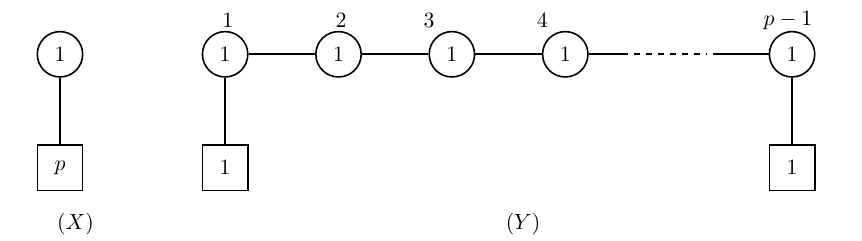
Figure 33 . The pair of Lagrangian theories associated with the 3d N = 4 SCFT that arise from the dimensional reduction of an ( A ) AD theory on a 1 , A 2 p − 1